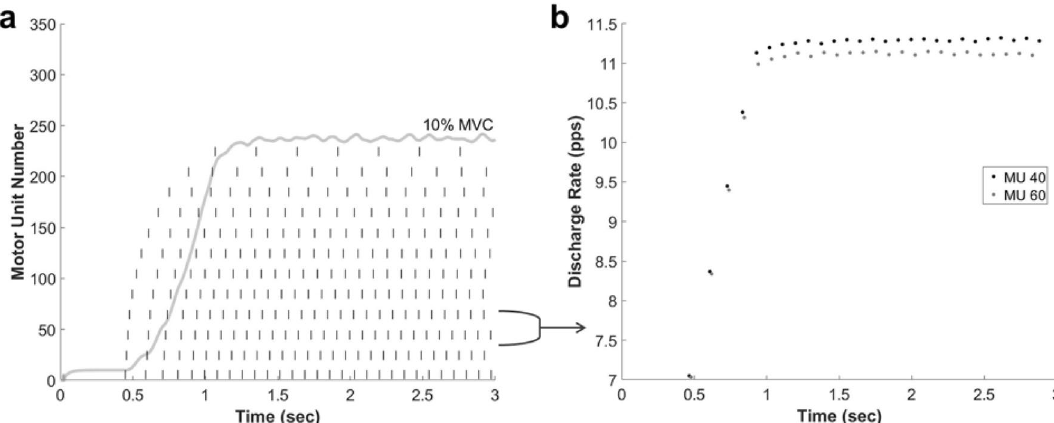
Figure 4. ( a ) Discharge times for every 20th motor unit (dashes) with resulting muscle force output (solid line). The stimulation profile increased linearly for one second until reaching the peak amplitude corresponding to 10% MVC, after which point it was held constant for two seconds. ( b ) Discharge rate, in pulses per second, of motor units 40 and 60 over the course of the simulation, showing the relationship between intensity and discharge rate to demonstrate rate coding.